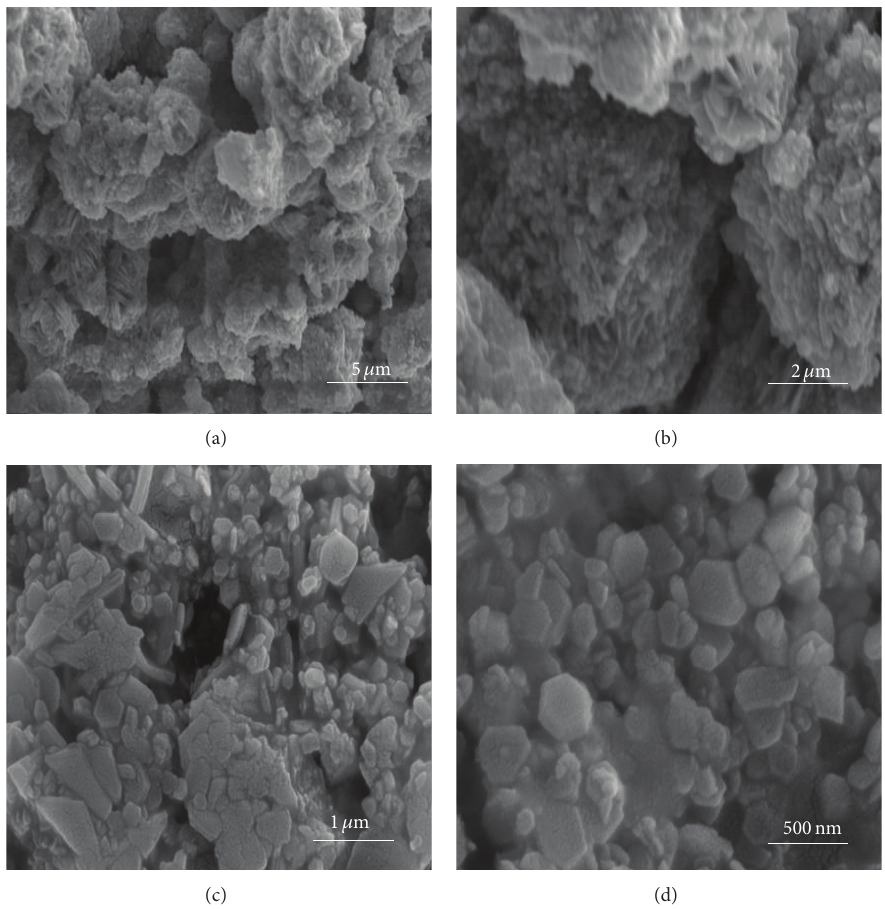
Figure 3: FE-SEM images of CuS nanostructures with CTAB at 150 ∘ C for 5 hrs at different